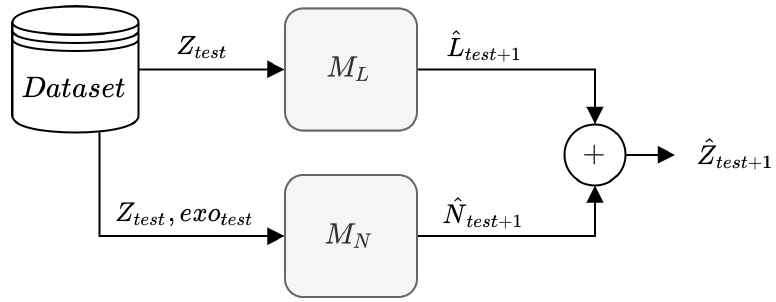
Figure 2. H-Transformer testing